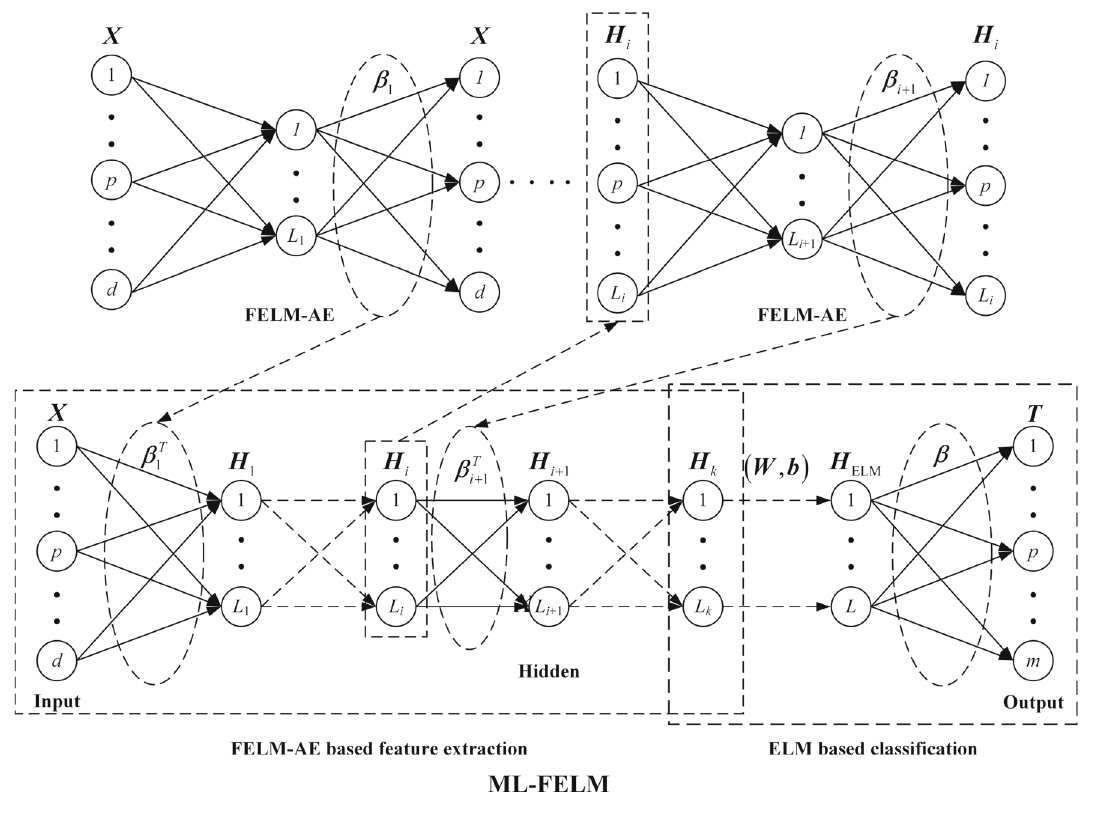
Fig. 3 Network structure of the ML-FELM Table 1 The datasets used in the experiments Datasets Attributes Categories Training